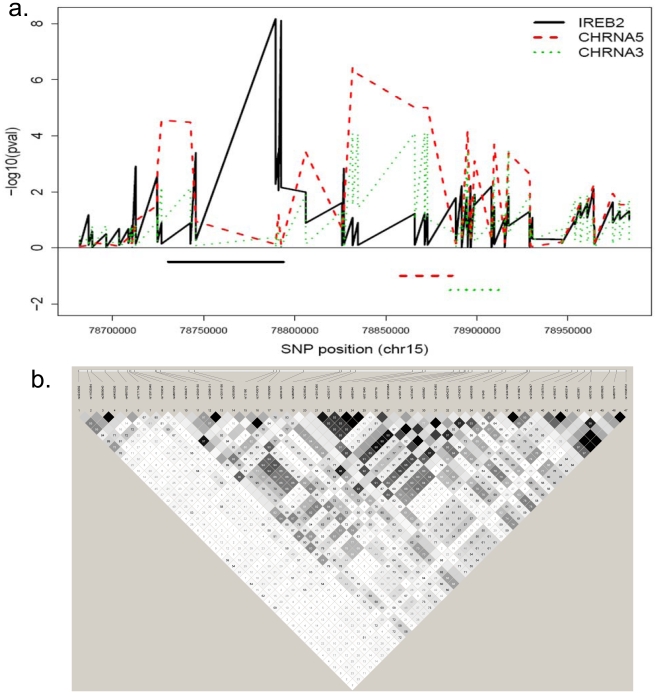
Detailed analysis of the chromosome 15q25 chronic obstructive pulmonary disease (COPD) locus.a) Association between single nucleotide polymorphisms (SNPs) in the chromosome 15q25 COPD locus and expression levels of IREB2 (1555476_at), CHRNA5 (206533_at) and CHRNA3 (211587_x_at) in sputum samples from 131 Evaluation of COPD Longitudinally to Identify Predictive Surrogate End-points (ECLIPSE) subjects. SNP rs numbers are listed in Table 4. b) Linkage disequilibrium r2 values between SNPs in the chromosome 15q25 COPD locus (listed in Table 4) in 131 ECLIPSE subjects.